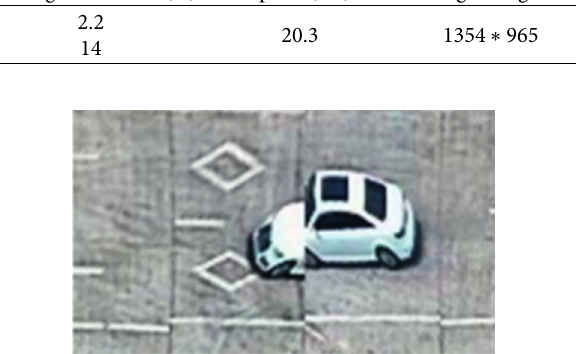
Figure 11: Vehicle image deformations’ sample.